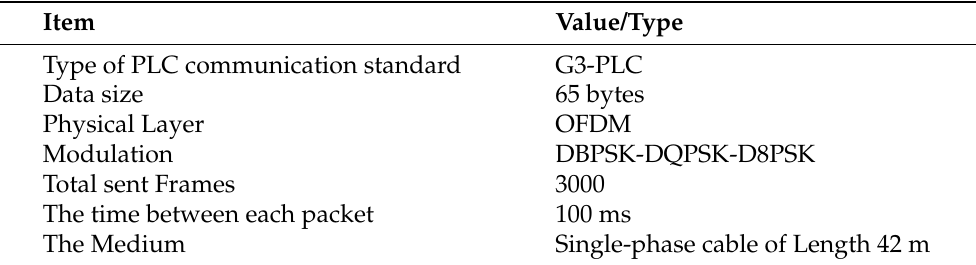
Table 3. PLC communication